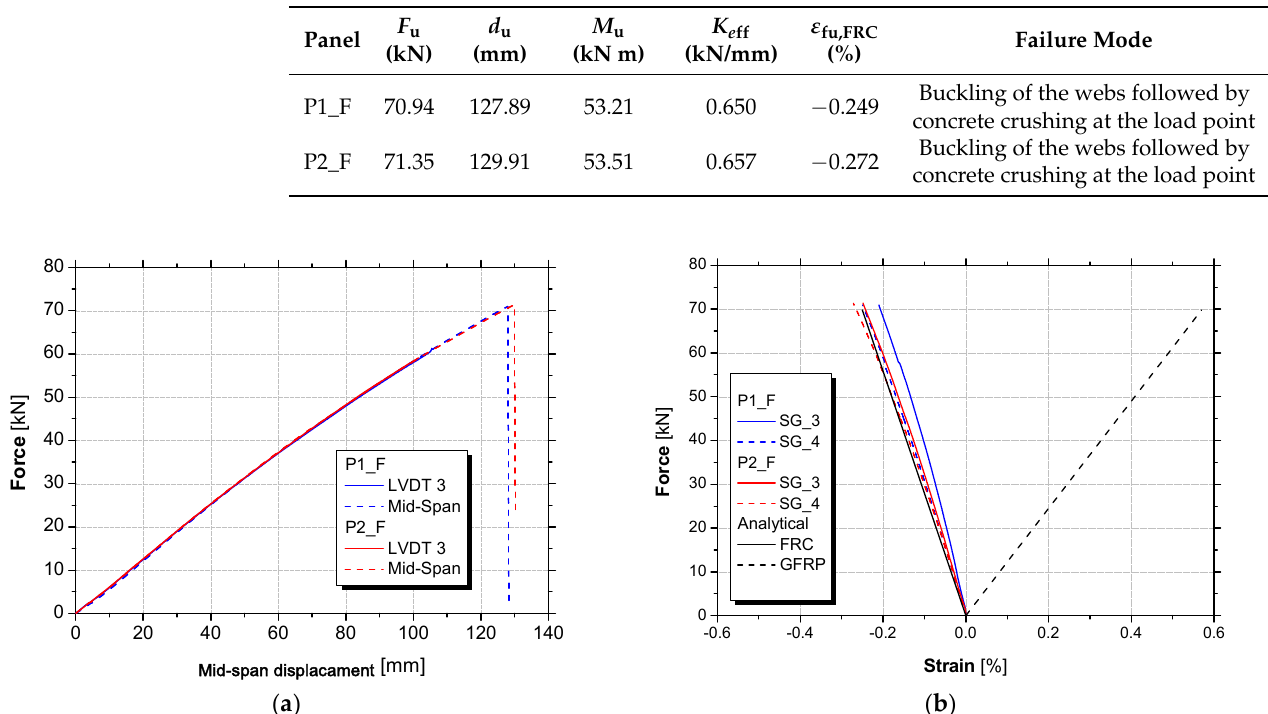
Figure 11. Flexural tests up to failure: ( a ) force versus midspan deflection and ( b ) force versus midspan strain in GFRP and FRC.